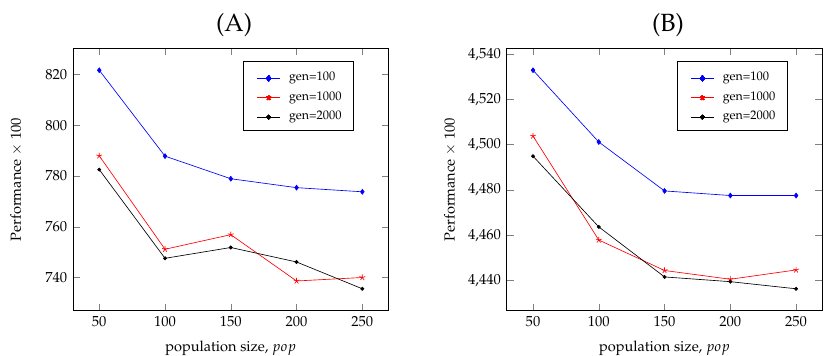
Figure 3. The performance of NSGA-III vs. different pop for different gen for ( A ) t 1 and ( B ) t 4.